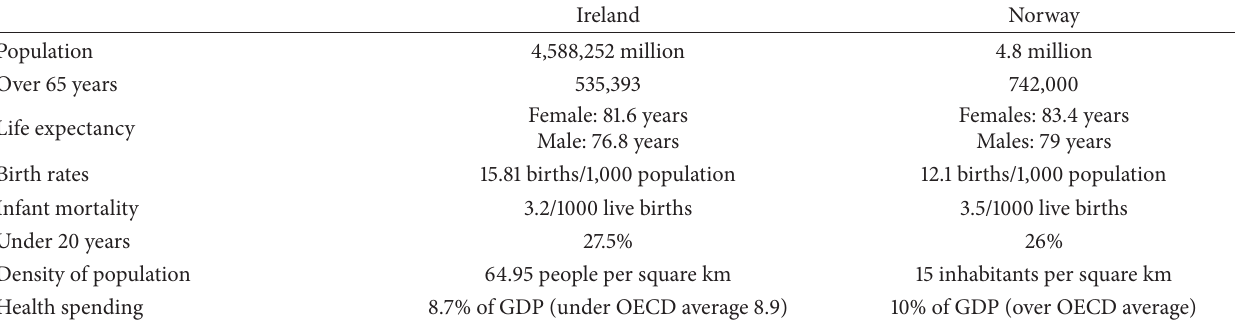
Table 1: Demography and vital statistics for Ireland and